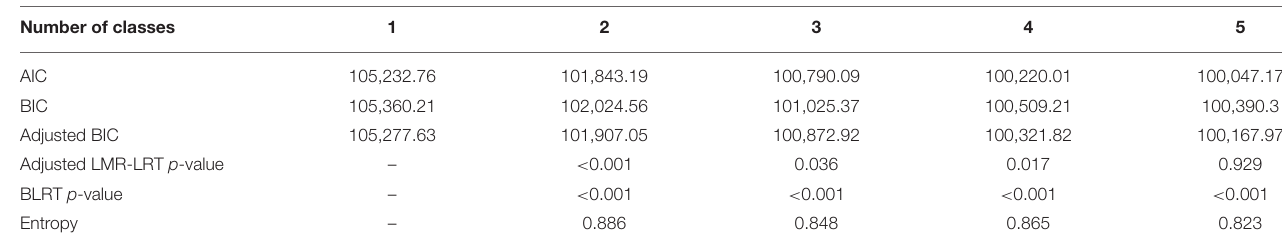
TABLE 1 | Fit indices of each class solution in the multigroup latent class growth